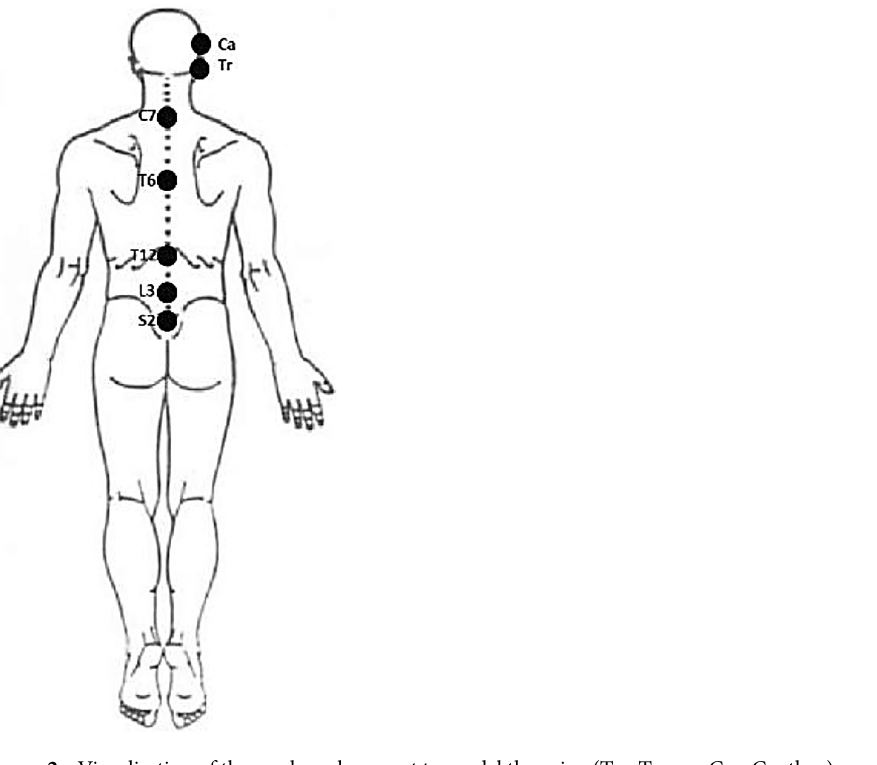
Figure 2. Visualisation of the marker-placement to model the spine (Tr = Tragus; Ca =